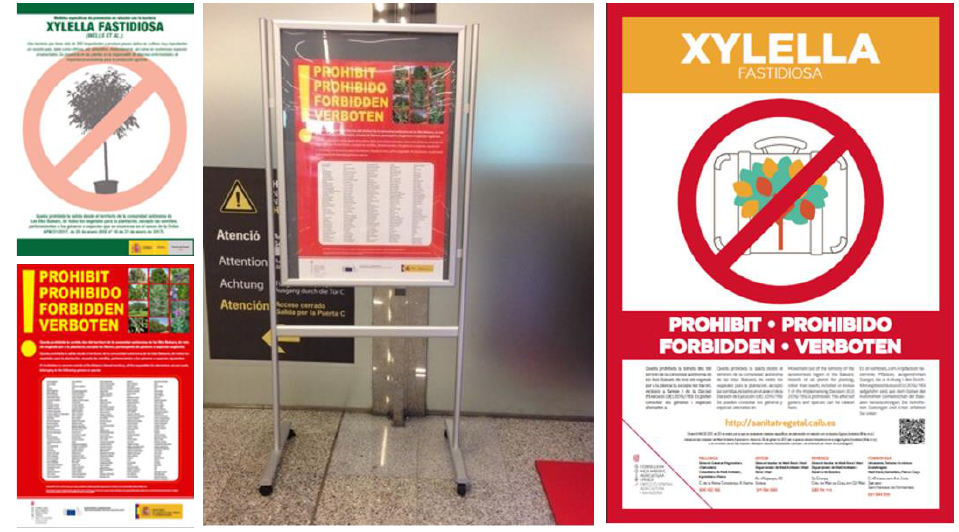
Figure 3. Informative, leaflet brochures, and posters of Xylella fastidiosa at the airport of Palma de Mallorca . de